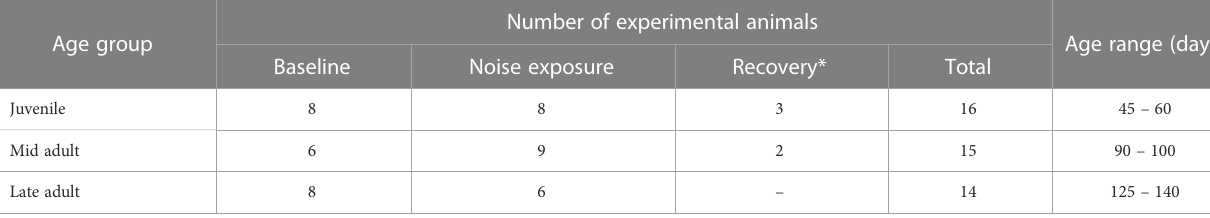
*Recovery animals (tested 2 hours post exposure) were a subset of the individuals used for noise